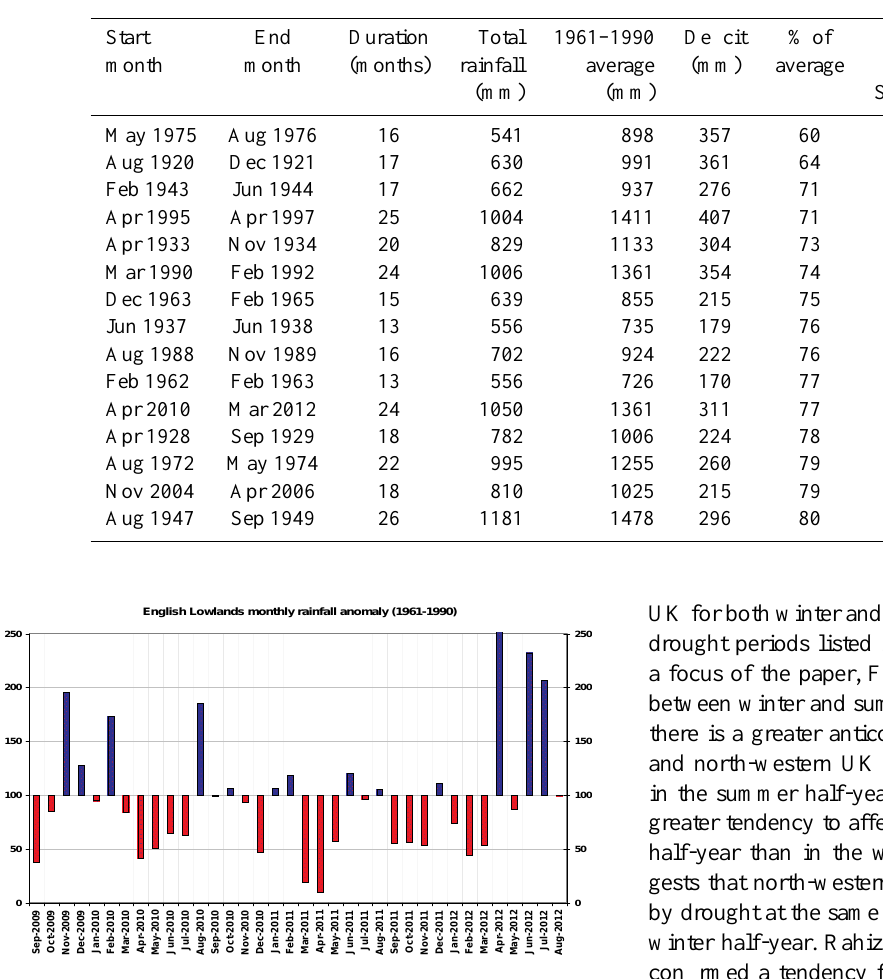
Figure 2. Example of a meteorological drought, April 2010 to March